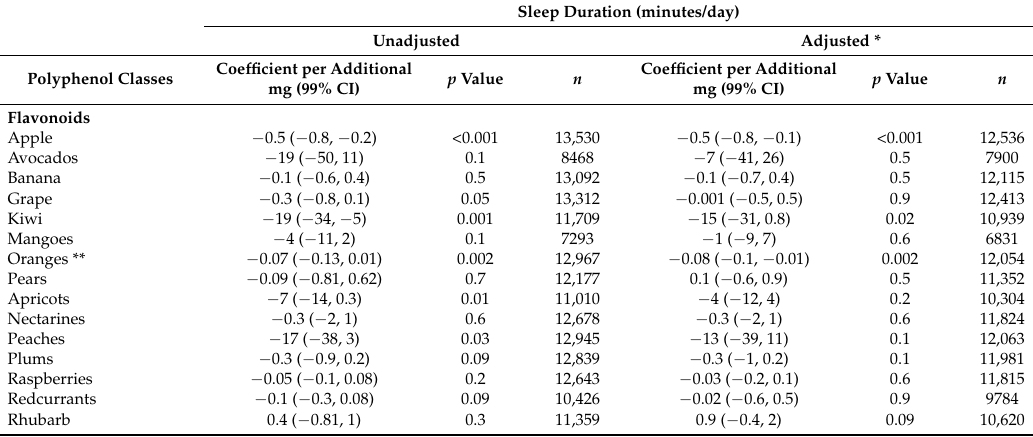
Table 4. The prospective associations between polyphenol classes from FV consumption and sleep duration in the